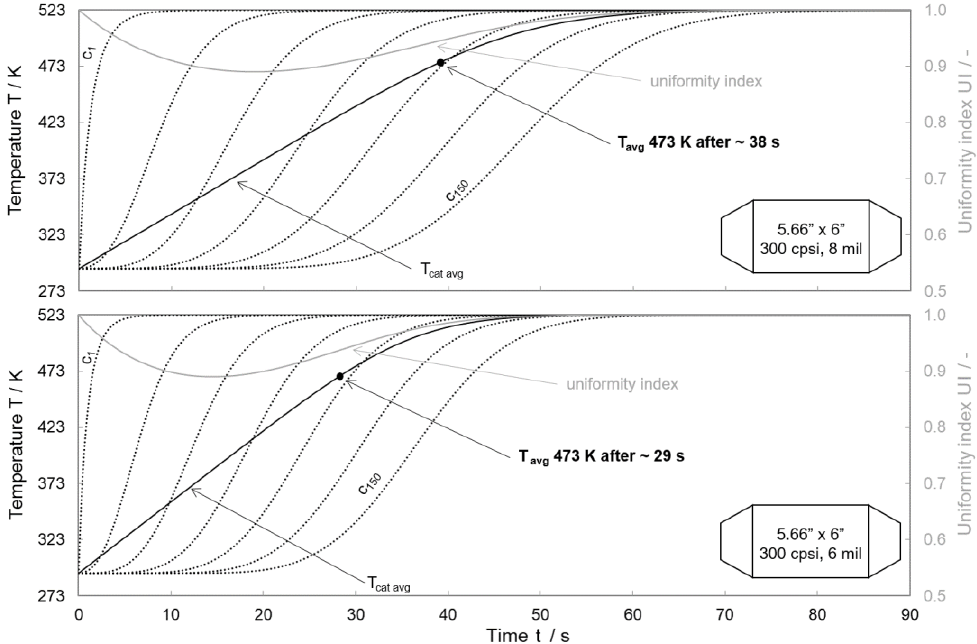
Figure 12. Steady state heat-up of 300 cpsi monoliths at a flow rate of 100 kg/h and 523 K.